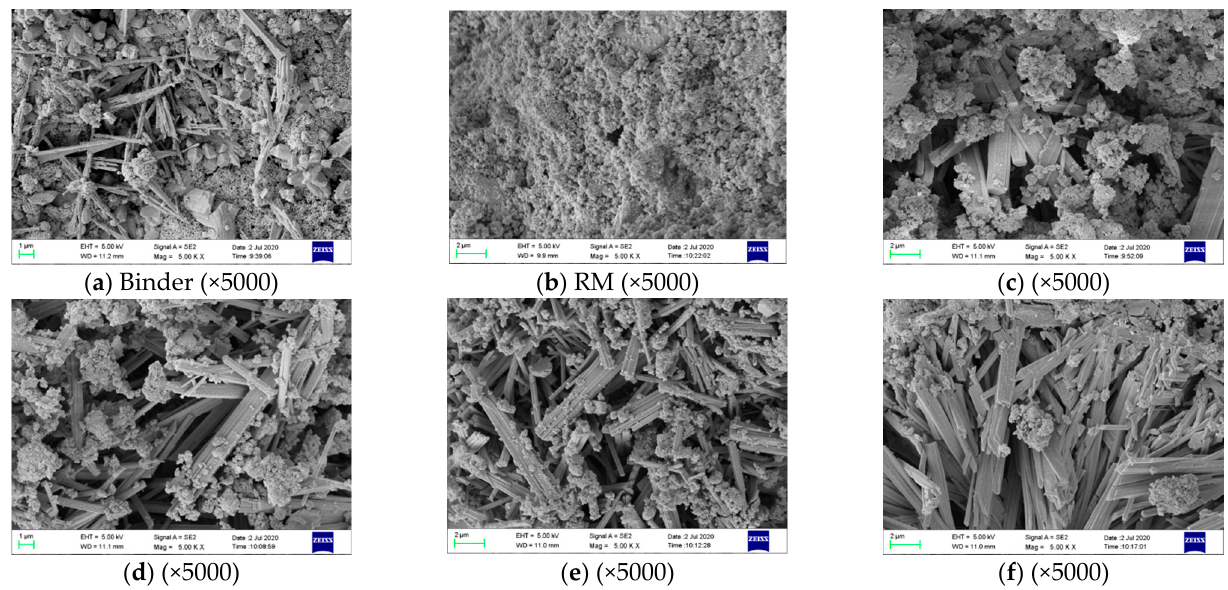
Figure 12. SEM images of binder, RM, and RM-based